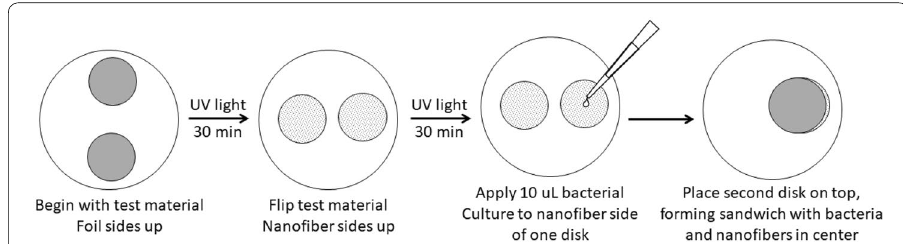
Fig. 1 Sterilization of samples with ultraviolet light and application of initial bacterial load. Inside a biological safety cabinet, disks of sample materials were placed in a plastic petri dish (without the lid) with the foil side up for the first 30 min exposure to UV light. Samples were flipped nanofiber‑side‑up and repositioned on the open dish before the second 30 min UV light exposure. S. aureus (10 µL culture) was applied to the nanofiber side of one disk, and disks were stacked as shown in the figure before incubation for 4 h at 37